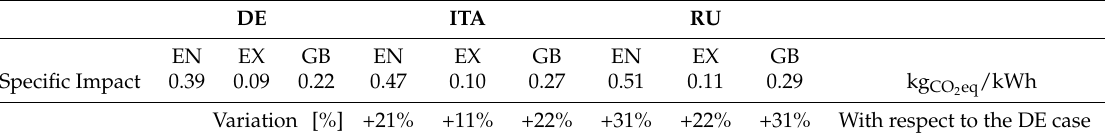
With respect to the DE